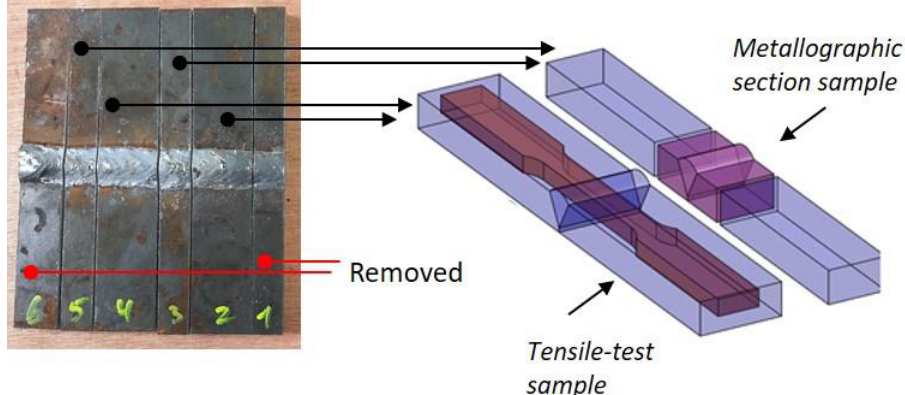
Figure 4. Sample preparation for metallurgical and mechanical characterization. Note the relative position of the FZ.